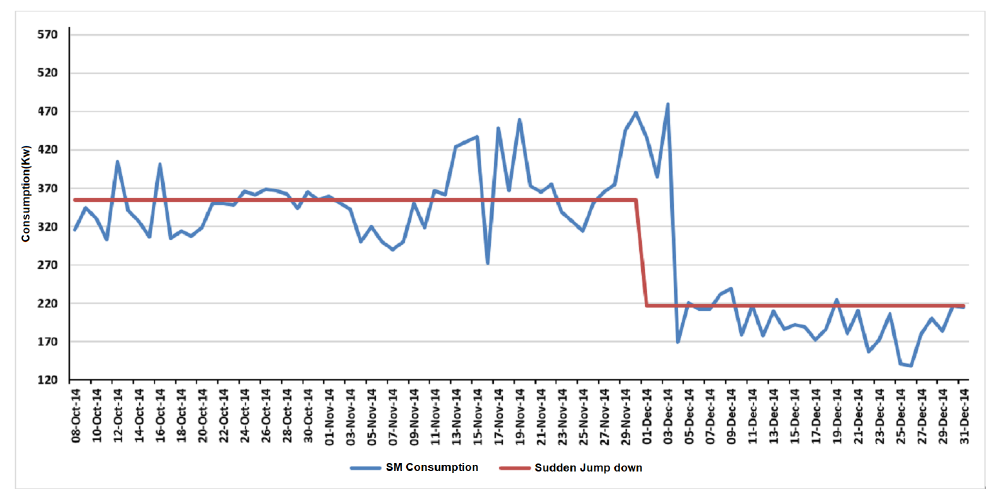
Figure 2. Sudden Jump down in the average Smart Meter usage of the attacker meter. The smart meter consumption in blue. The jump in between the mean of lag meter readings and the mean of the lead meter-readings (red color) at the fraudulent point.